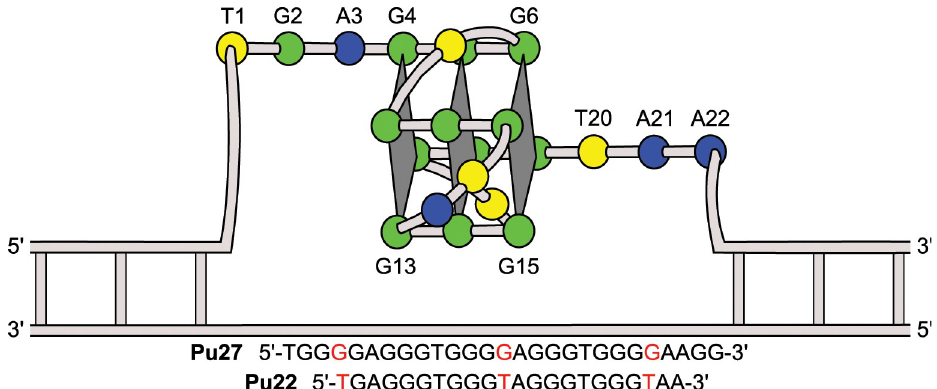
Fig 1. Topology of the c-MYC promoter quadruplex. Diagram showing fully parallel topology of the c-MYC promoter quadruplex crystal structure with all reversal loops continuing in the right to left direction (5’ to 3’). Thymines are represented in yellow, adenines in blue, and guanines in green. Sequence modifications in Pu22 are shown highlighted in red.